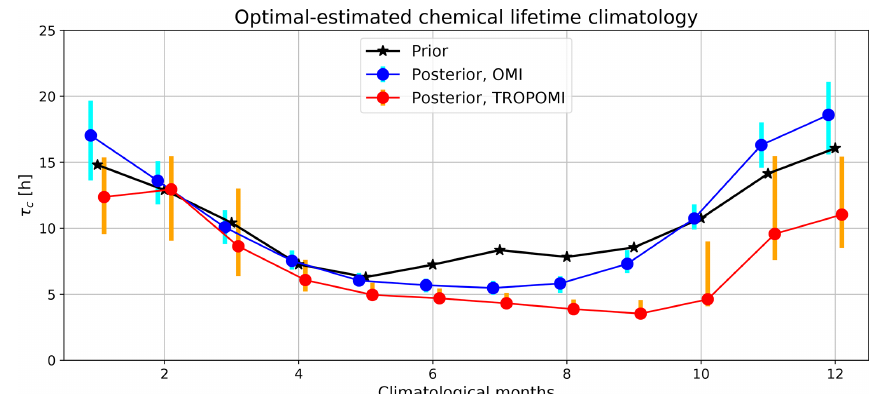
Figure 9. Prior (black) and posterior (blue for OMI and red for TROPOMI) climatological chemical lifetimes from optimal estimation. The prior chemical lifetimes are based on nonlinear fitting to the climatological column–wind speed relationships. The error bars indicate 95% confidence intervals by bootstrapping the calendar months used to construct each climatological column–wind speed relationship.